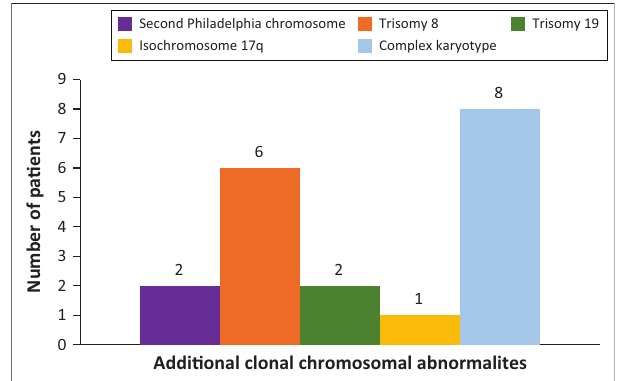
FIGURE 1: Frequency of additional clonal chromosomal abnormalities in patients with CML in blast phase ( N = 16) Johannesburg, South Africa, 08 April 2016 to 16 October 2019. Cytogenetics analysis was available for 16 patients. Additional clonal chromosomal abnormalities was identified in 11 patients. Five of the karyotypes demonstrated multiple additional clonal chromosomal abnormalities. Trisomy 19 and isochromosome 17q were always present with a trisomy 8.